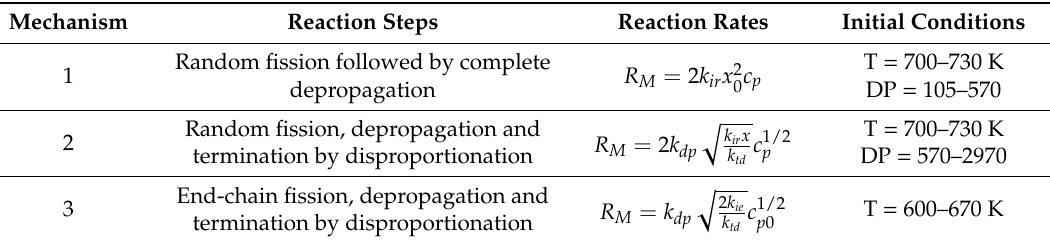
Table 6. Simplified rate laws reported by Barlow et al. [123] a . Mechanism